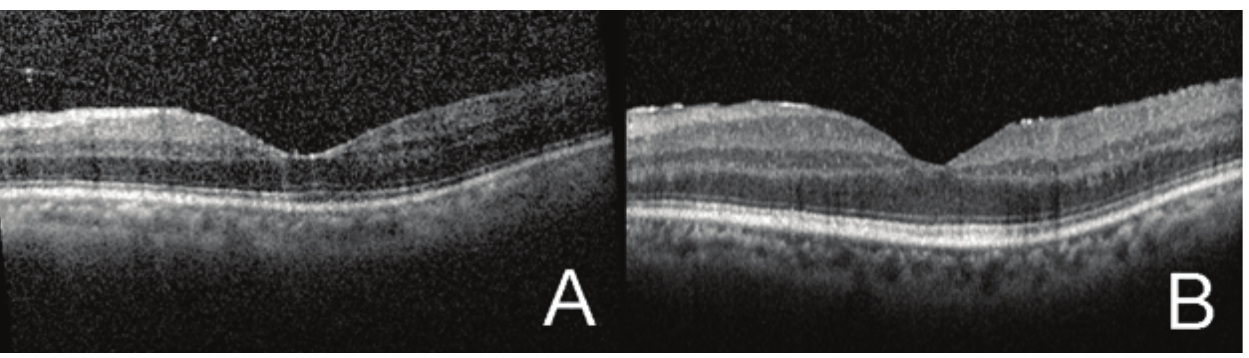
Figure 2. (A) OCT of the macula of the left eye before treatment initiation showing vitreomacular adhesion and few vitreous cells. (B) OCT of the macula of the left eye after 10 weeks from treatment initiation showing a fine epiretinal